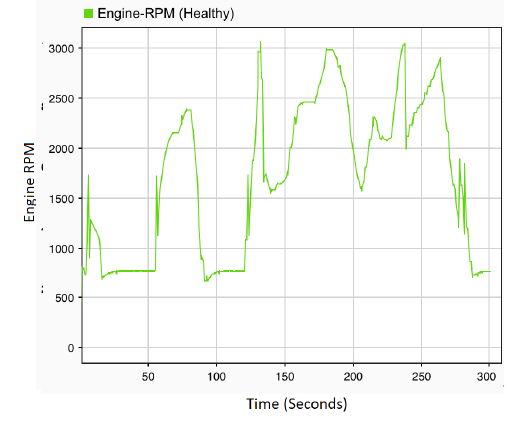
Figure 3. Fault-free/healthy signal.